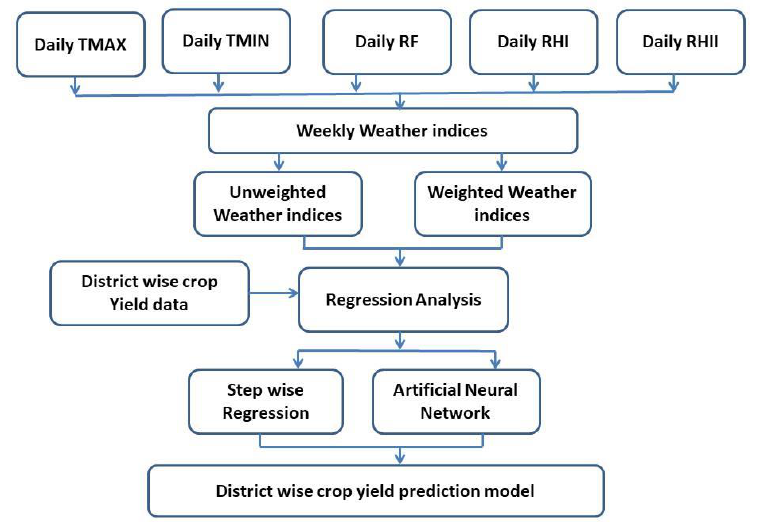
Figure 2. Flowchart representing the different stages of model calibration and validation. Table 2. Weather-derived indices used in models using composite weather variables.